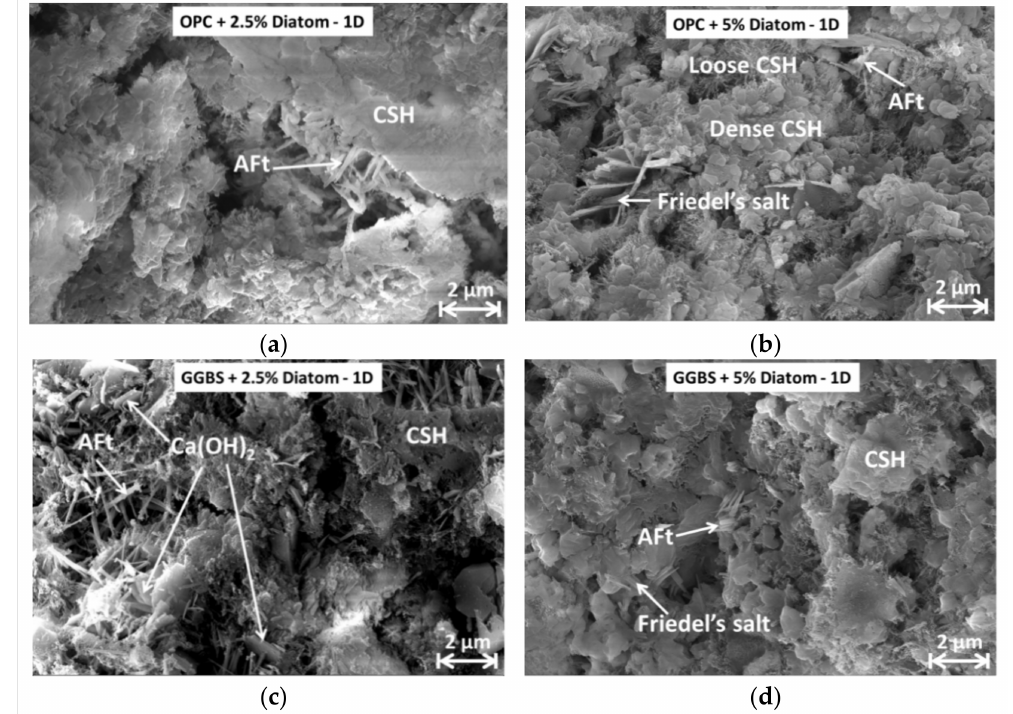
Figure 6. Microstructure observations of different paste samples under SEM at 1D: ( a ) OPC + 2.5% diatom, ( b ) OPC + 5% diatom, ( c ) GGBS + 2.5% diatom, ( d ) GGBS + 5%